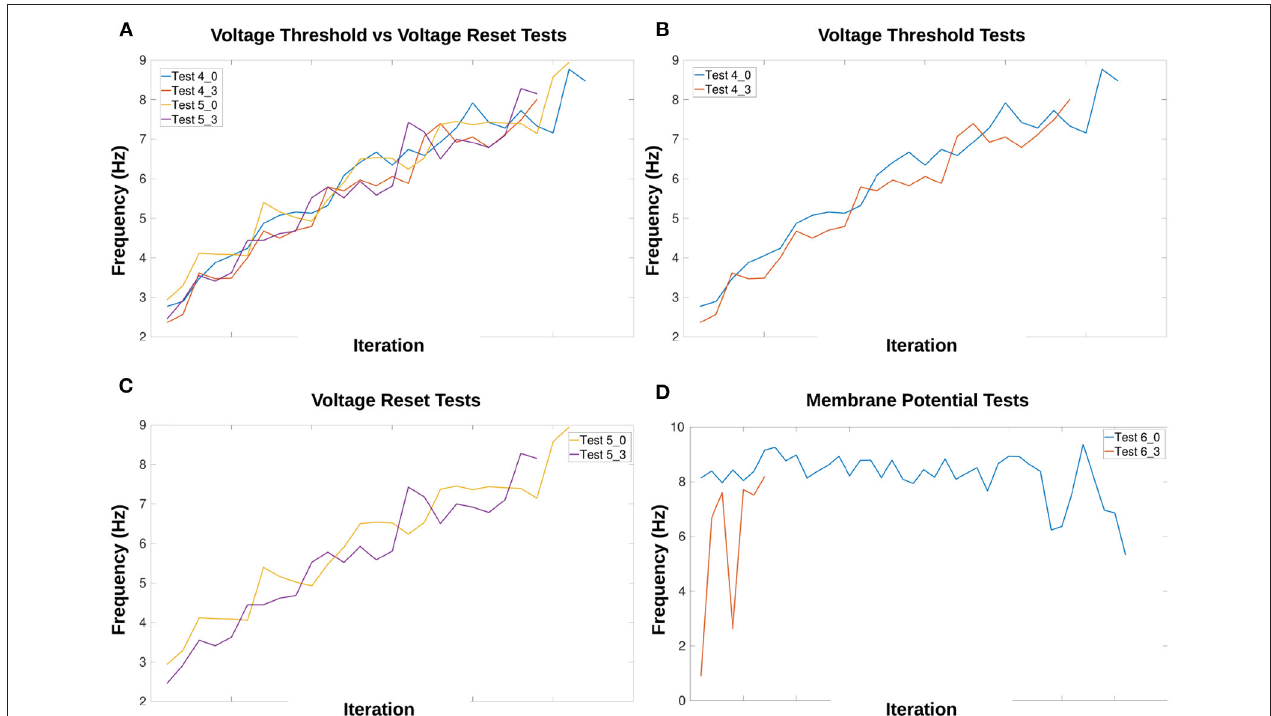
FIGURE 9 | Calculation of frequency for each voltage characteristic manipulation using the time difference between peaks. Double peaks are removed as outliers. The x-axis only represents iteration through the array by subtracting the previous array element from the current element, it does not indicate time. The frequency of the MNP output trends upwards for (A–C) , indicating that peaks occur more frequently when the absolute difference in voltage between V reset and the V th is decreased. The suffix 0 is used for excitatory tests and 3 for inhibitory tests. (A) Compares peak frequencies of V th and V reset ; (B) V th ; (C) V reset ; (D) V m . See Tables 1 , 2 and Figures 4 , 5 for setup and details per test number.